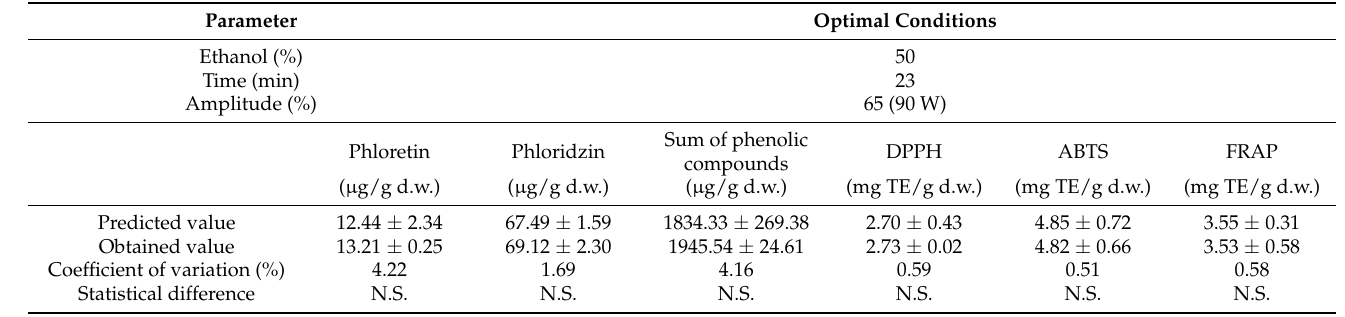
Table 4. Optimal conditions selected and the model predicted values with the obtained values expressed as the mean and the standard deviation.